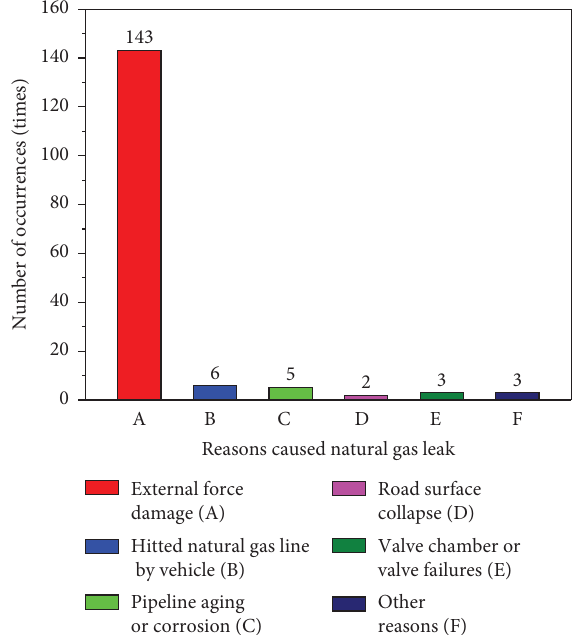
Figure 3: Statistics of causes of outdoor natural gas accidents in China in 2021 (source: the national gas explosion accidents in 2021 from the National Bureau of Statistics).